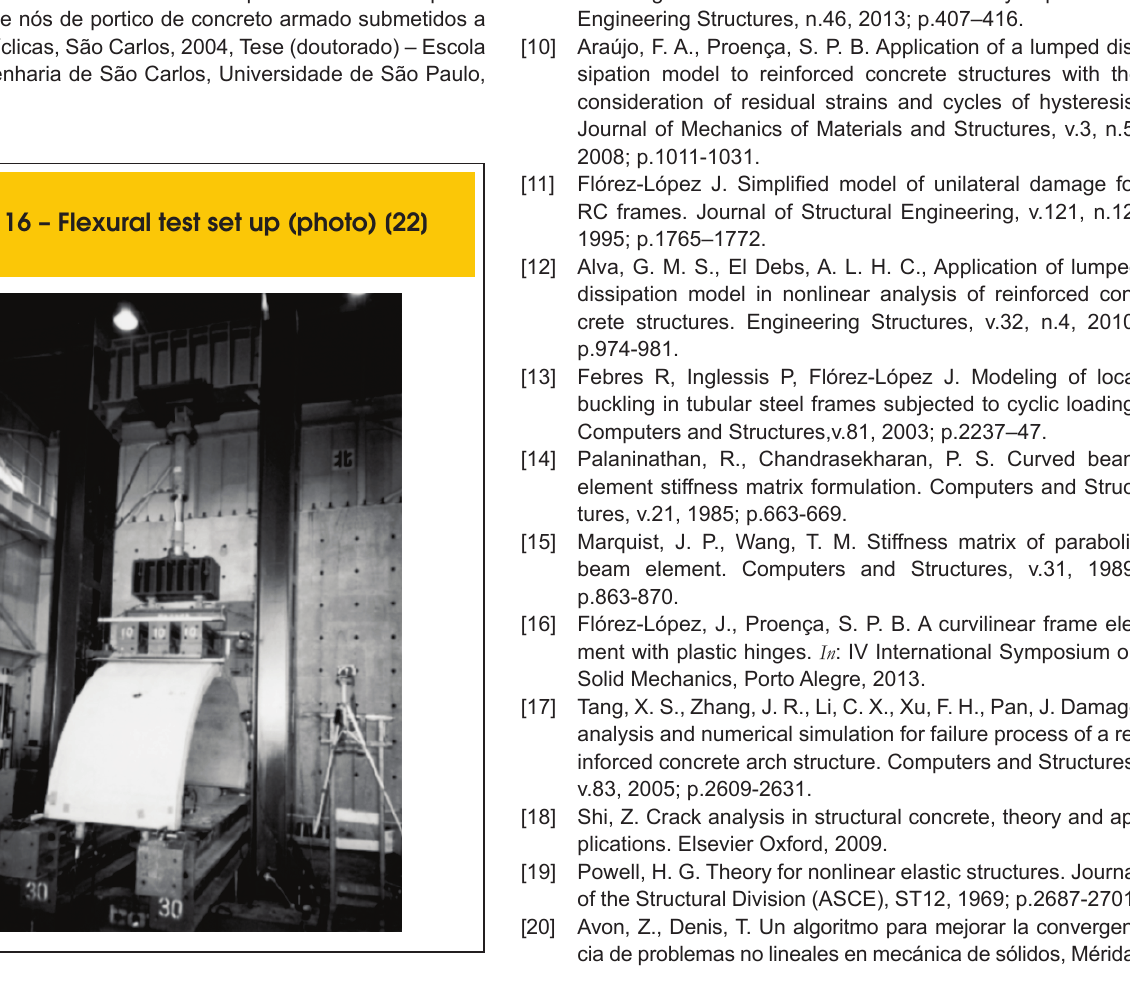
Figure 17 – Flexural test set up